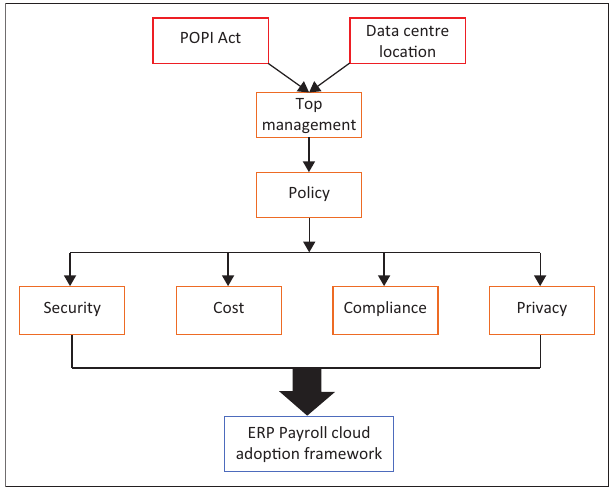
FIGURE 2: Proposed enterprise resource planning payroll cloud adoption framework.